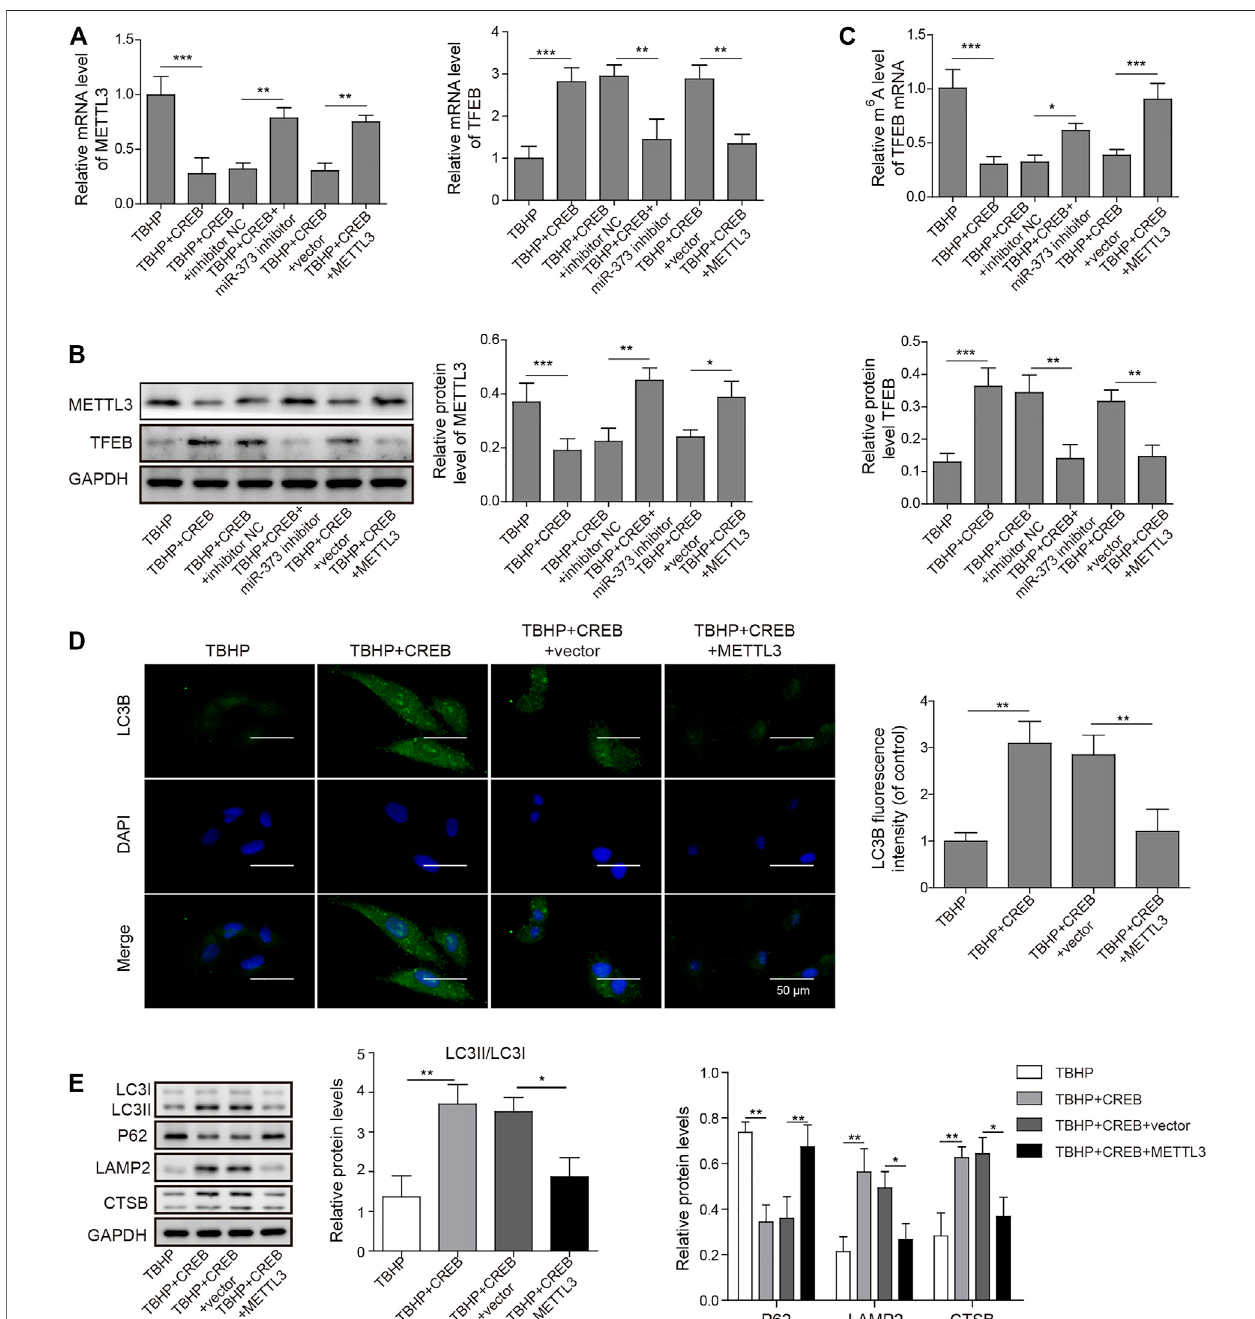
FIGURE 5 | Overexpression of METTL3 overturned the CREB-promoted autophagic fl ux. (A) The expression of METTL3 (left) and TFEB (right) were con fi rmed by qRT-PCR. GAPDH was used as an endogenous reference. (B) The changes of the protein of METTL3 and TFEB in the experiment above were determined by Western blotting.Quanti fi edintensityofthebandswasnormalizedtoGAPDHtogeneratethecolumnchart. (C) Thechangesofm6AofTFEBmRNAindifferenttreatmentsabove. (D) Theimpactontheautophagic fl uxwasdetermined bytheimmuno-stainingofLC3B.LC3B fl uorescenceintensitywasmeasuredanddatafromallgroupswere normalized to the TBHP group. (E) The changes of the essential regulators or markers ofapoptosis and autolysosome were determined by Western blotting. Quanti fi ed intensity of the bands was normalized to GAPDH to generate the column chart. p < 0.05 was marked as *, p < 0.01 was marked as **, p < 0.001 was marked as ***.